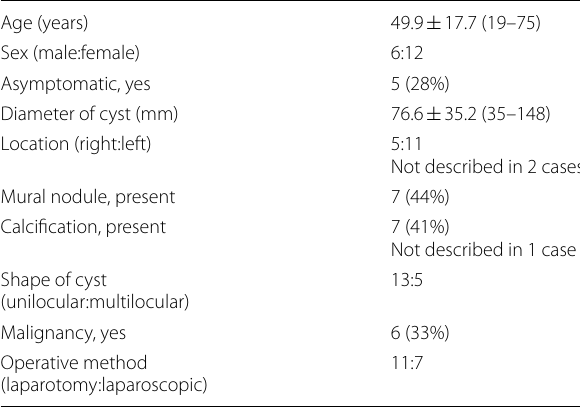
Table 1 Clinical features of retroperitoneal isolated enteric duplication cyst in adults ( n =